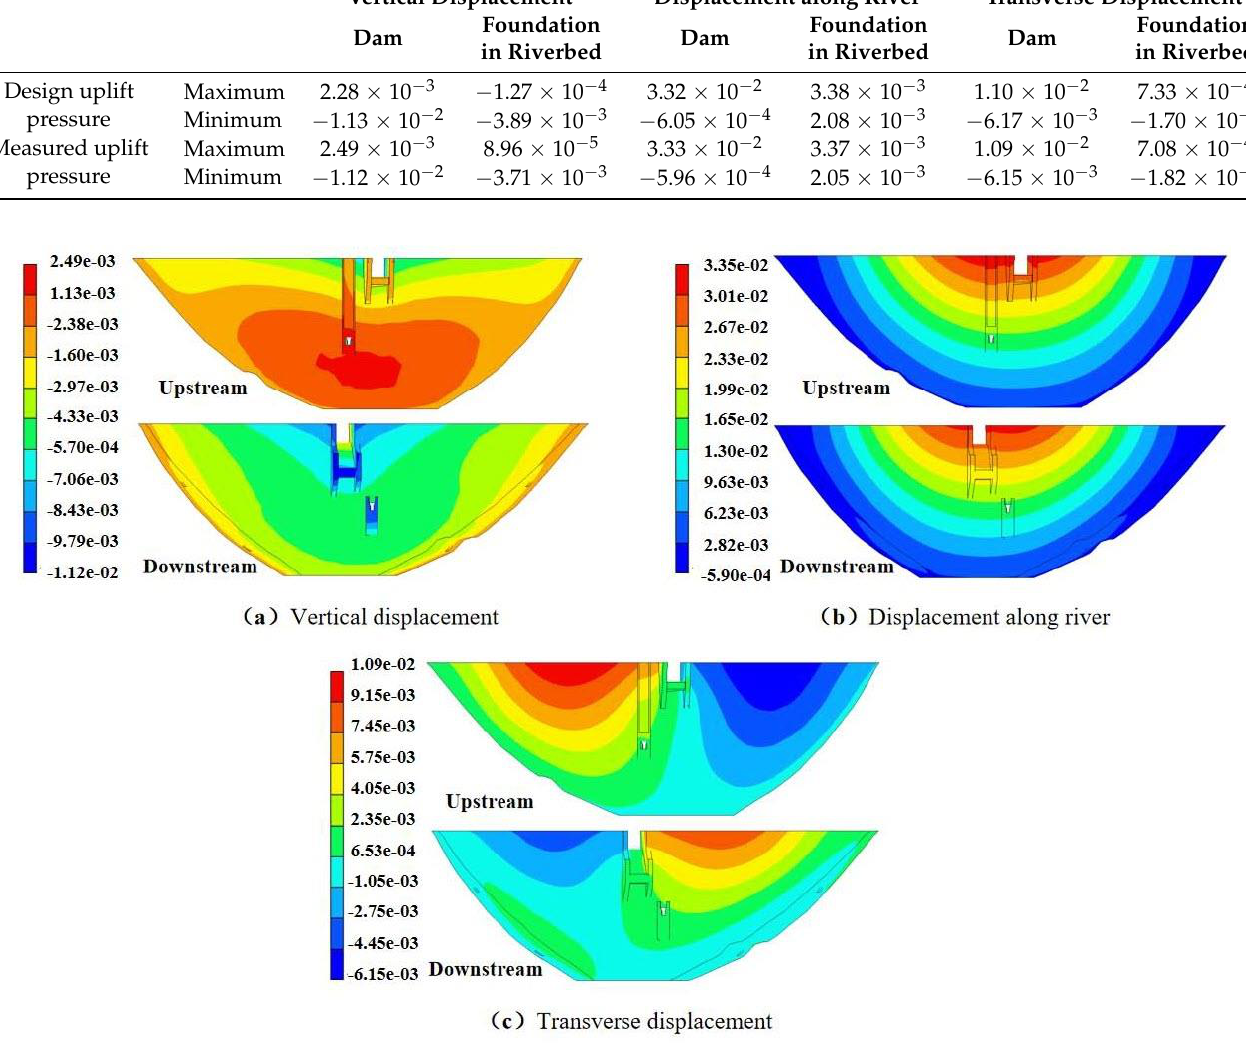
Figure 15. Contour map of dam displacement under measured uplift pressure (Unit: m).